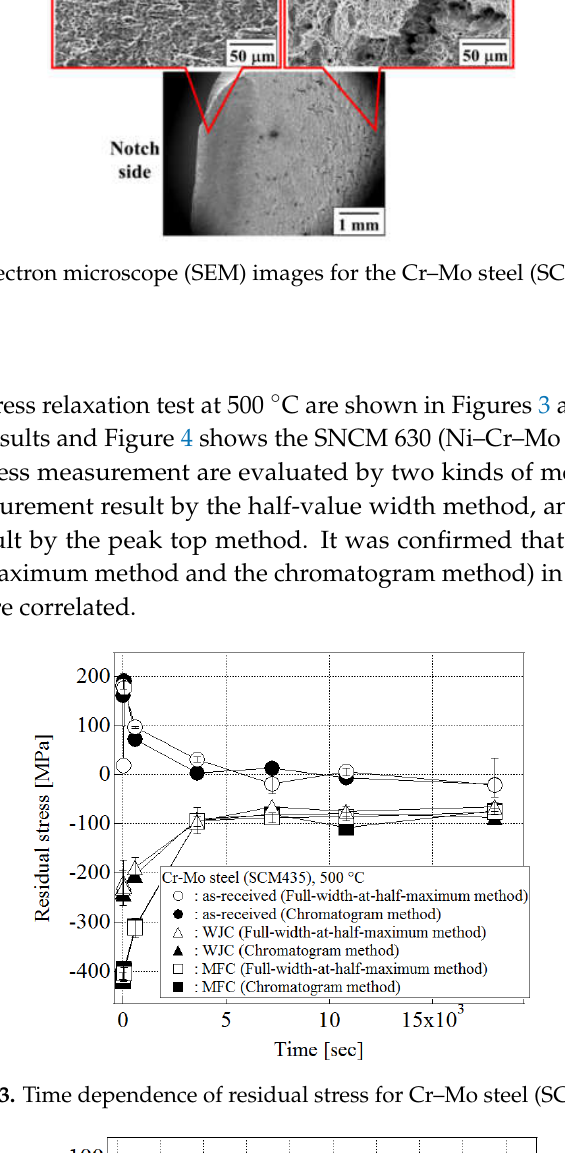
Figure 2. Scanning electron microscope (SEM) images for the Cr–Mo steel (SCM435) (MFC) Charpy impact test.